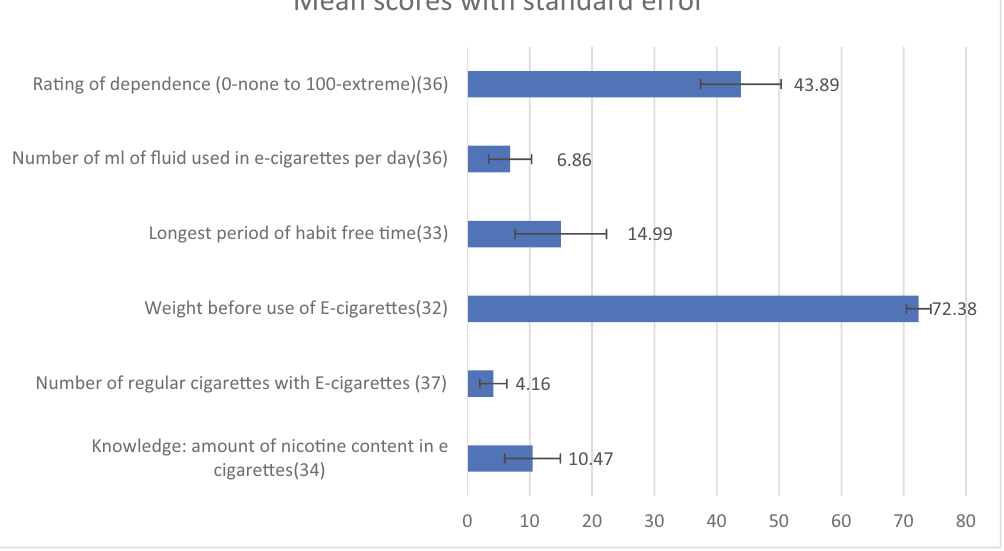
Figure 2: The mean scores of age and usage details of e - cigarette habits.